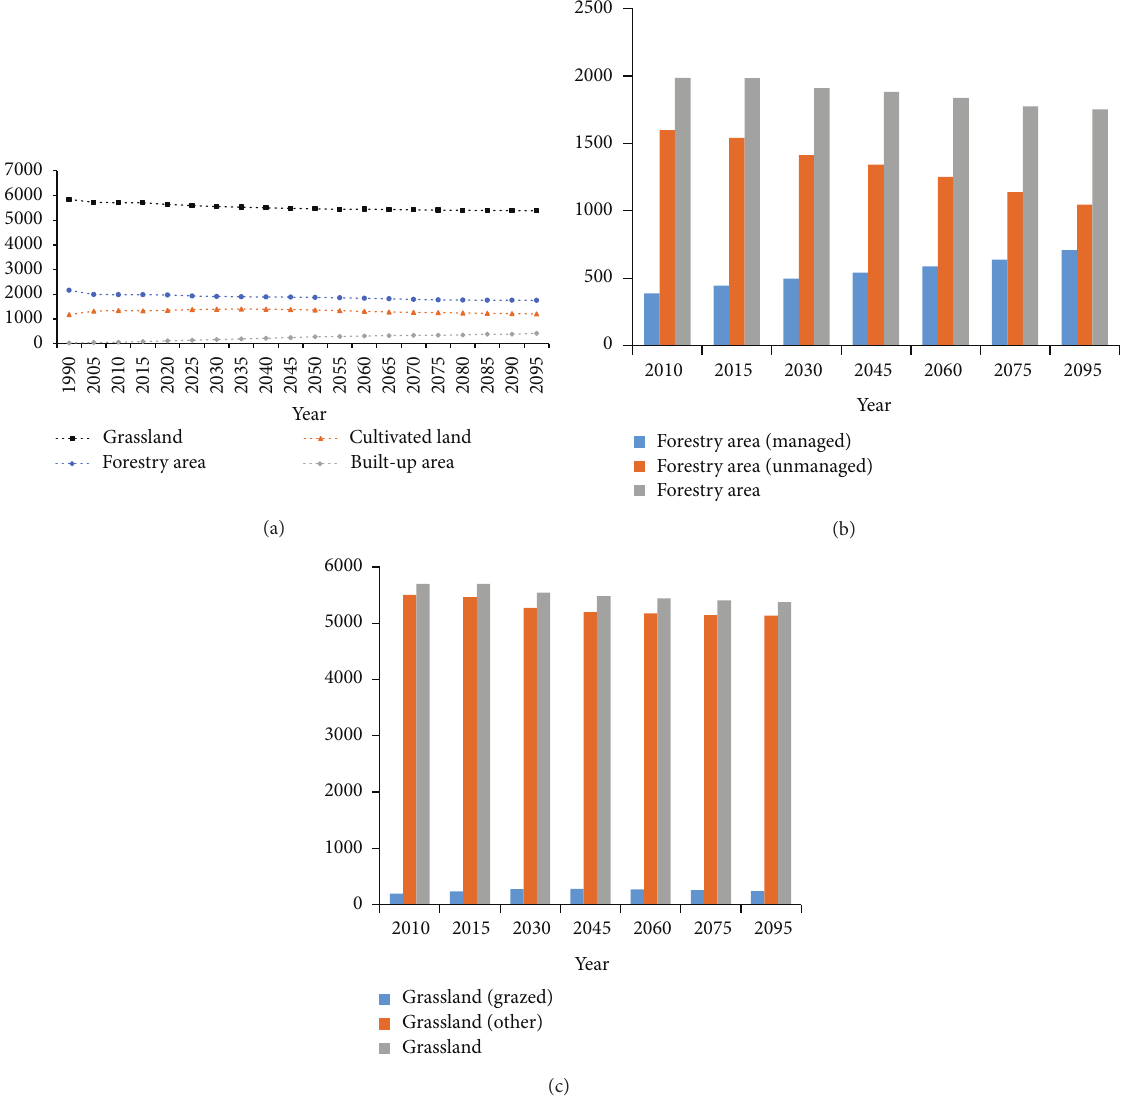
Figure 4: Land use change trends of China under REG scenario during 1990–2095; (a) land use change trends of cultivated land, forest land, grassland, and built-up land; (b) trends of managed and unmanaged forest land; (c) trends of grazed and other grassland (unit: 1000km 2